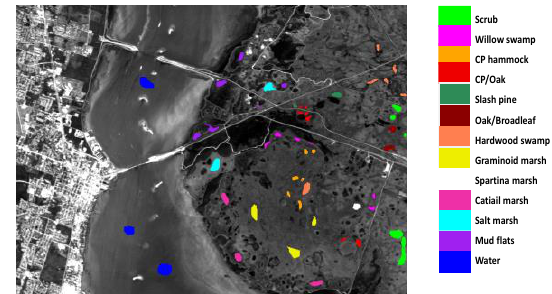
Table 1 Land-cover classes and the number of pixels for the Pavia University dataset